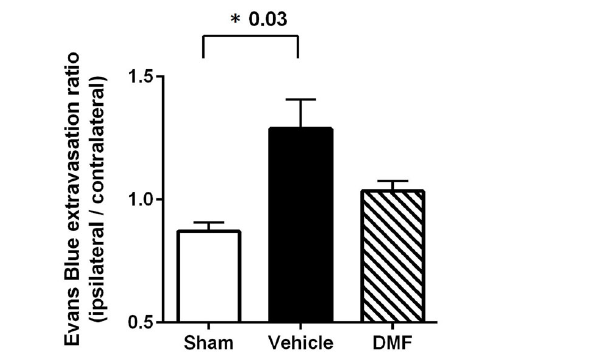
FIGURE 2 - Alterations in the permeability of the blood-brain barrier in rats three days after middle cerebral artery occlusion (MCAO). Quantitative analysis of Evans blue extravasation ratio (ipsilateral/ contralateral) from rat brain extracts at 72 hours after MCAO (n=5 rats/group). * P<0.05 .